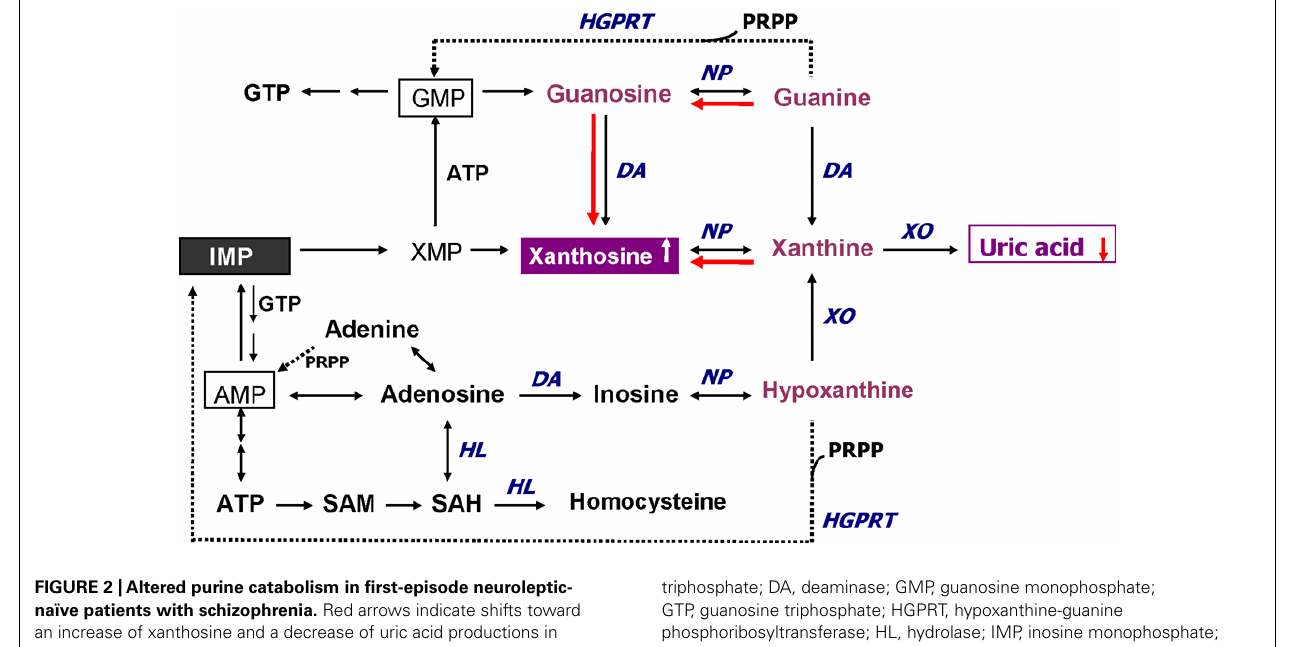
FIGURE 2 |Altered purine catabolism in first-episode neuroleptic- naïve patients with schizophrenia. Red arrows indicate shifts toward an increase of xanthosine and a decrease of uric acid productions in FENNS patients at baseline. Reactions shown with dotted lines represent the “salvage pathways,” which purine bases can be reutilized resulting in considerably energy saving for the cell. ADP, adenosine diphosphate; AMP, adenosine monophosphate; ATP, adenosine